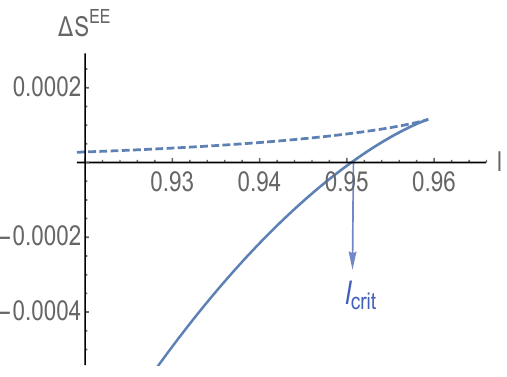
(cid:0) S EE as a function con discon